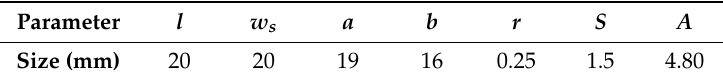
Table 1. Oval-shaped metamaterial